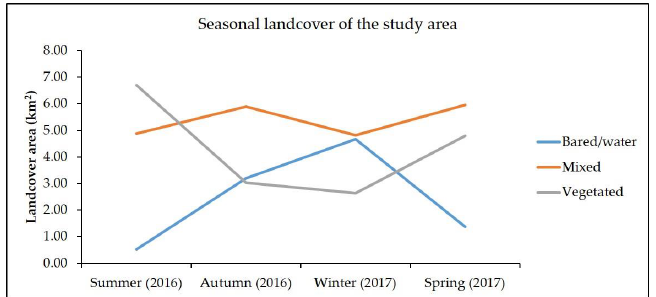
Figure 13. Comparison of the areas of various land cover types within the study area for four seasons covering the period from June 2016 to April 2017. Remote Sens. 2018 , 10 , x FOR PEER REVIEW